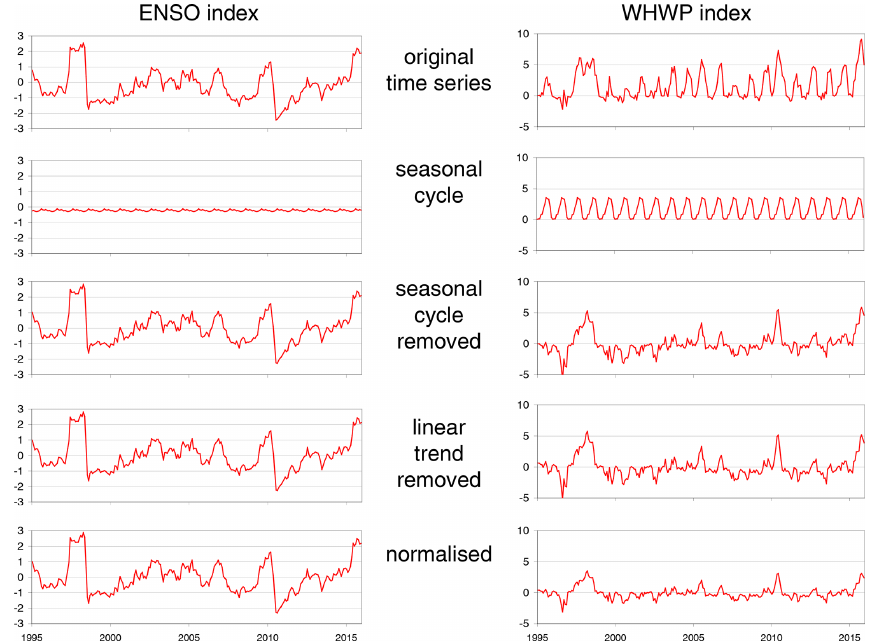
Figure A7. Illustration of the preparations for the indices before they are used in the fit to the global data sets: first, the mean seasonal cycles and linear trends are subtracted. Then the differences are normalised by their standard deviations.